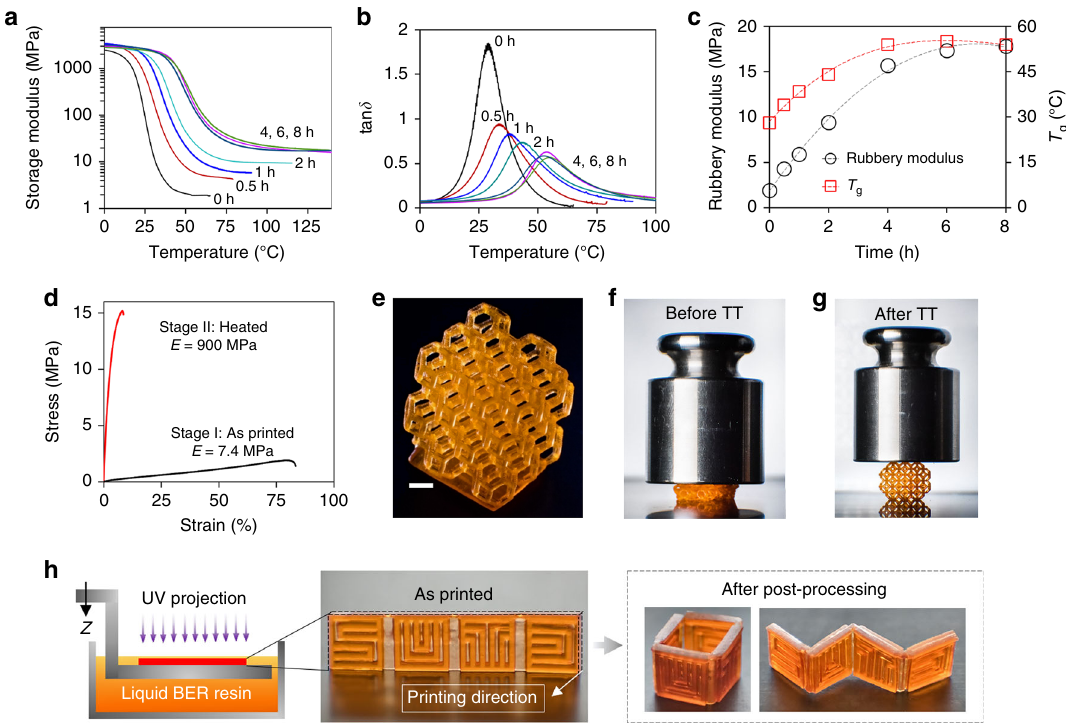
Fig. 2 Reshapability of 3D printing reprocessable thermosets. a – c Dynamic mechanical analysis (DMA) tests to investigate the effect of thermal treatment on mechanical properties of samples printed with reprocessable thermosets. d Uniaxial tensile tests of printed samples before and after the 4 h thermal treatment at 180 °C. Demonstration of stiffness change of a printed Kelvin foam ( e ), before ( f ), and after ( g ) thermal treatment (TT) at 160 °C for 12 h. h Demonstration of combining 3D printing with traditional thermoforming to expand capability and reduce time of manufacturing. Scale bar: 1